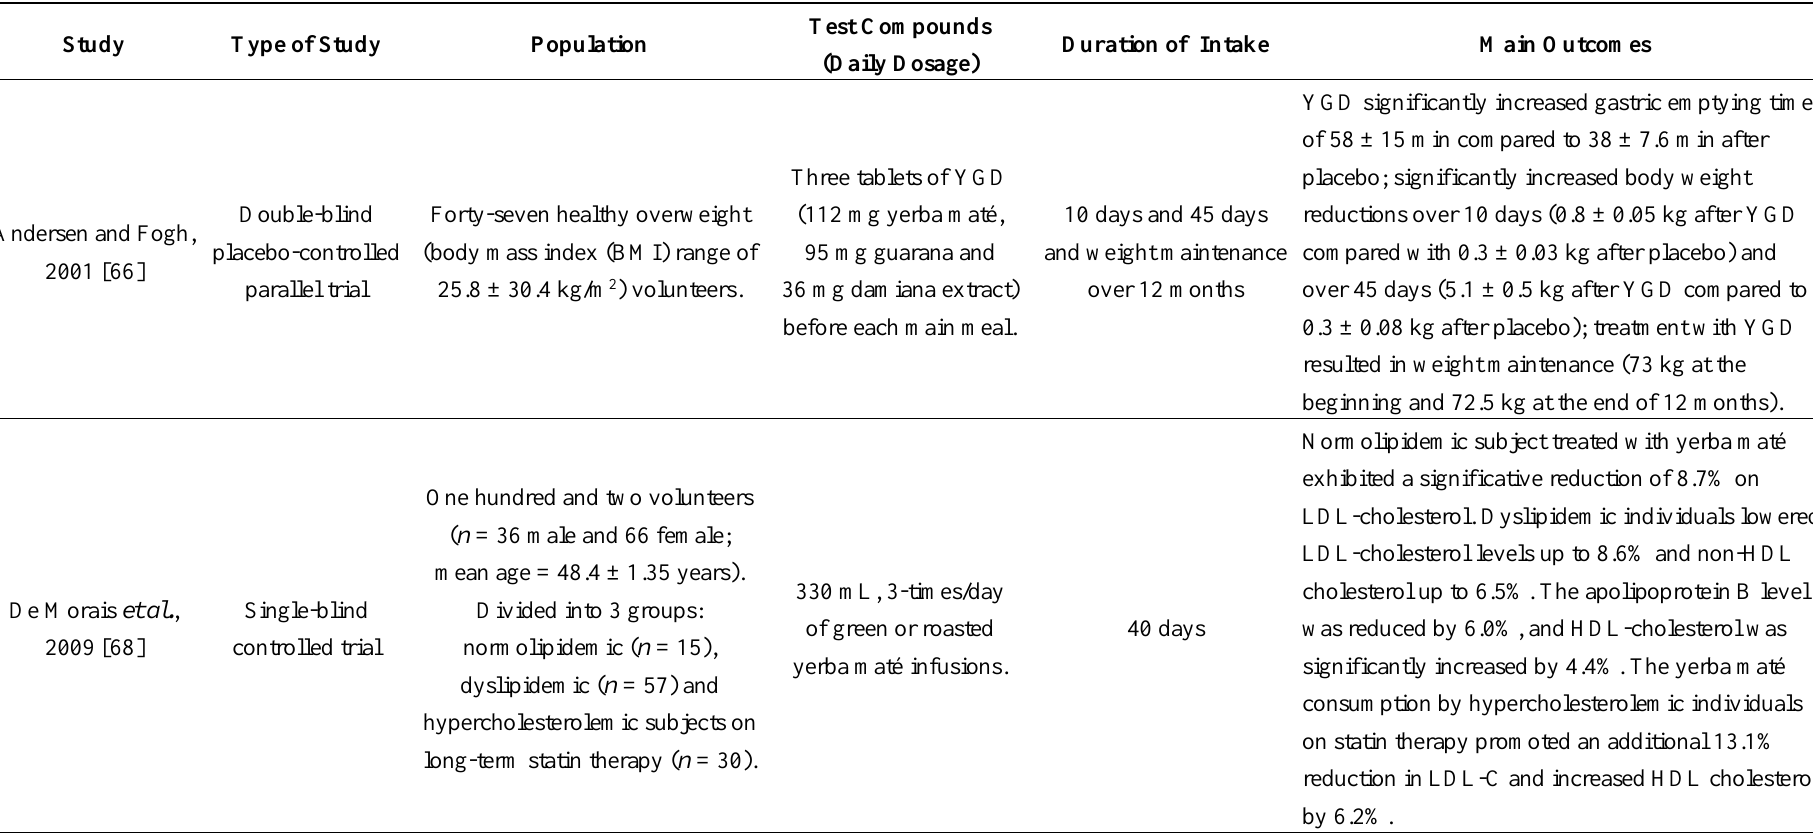
Table 1. In vivo effects of yerba maté on adipogenesis: human and animals